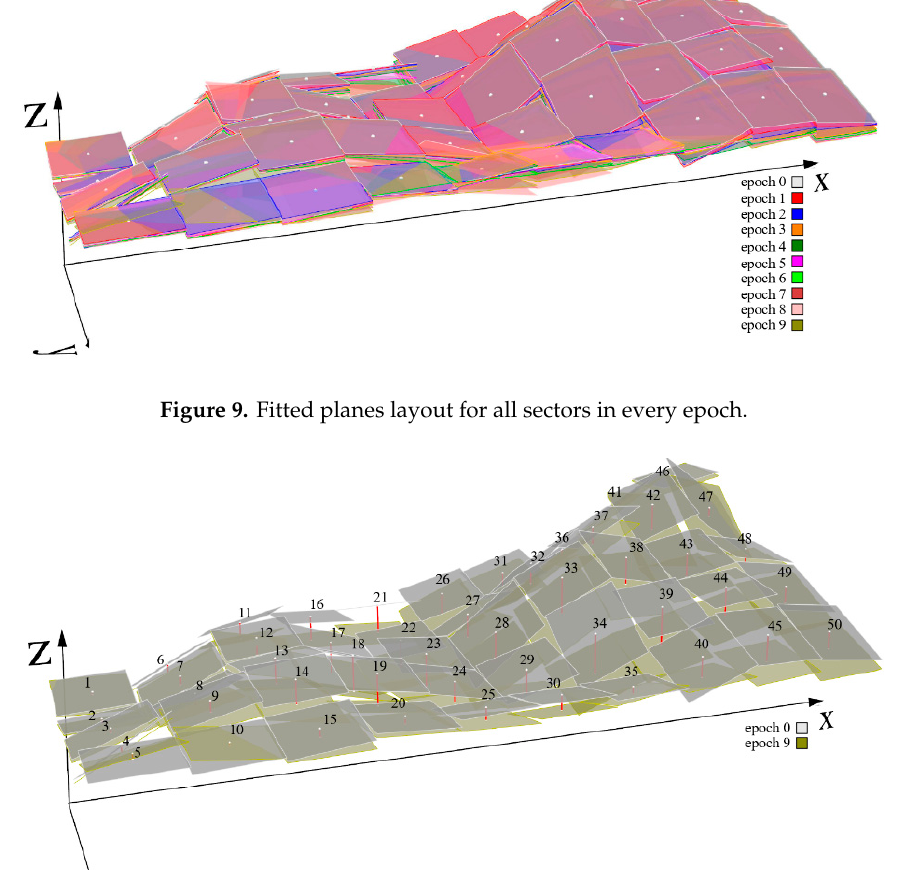
Figure 10. Fitted planes layout comparison between the initial and last epoch. Distances between centroids are illustrated with red line segments.